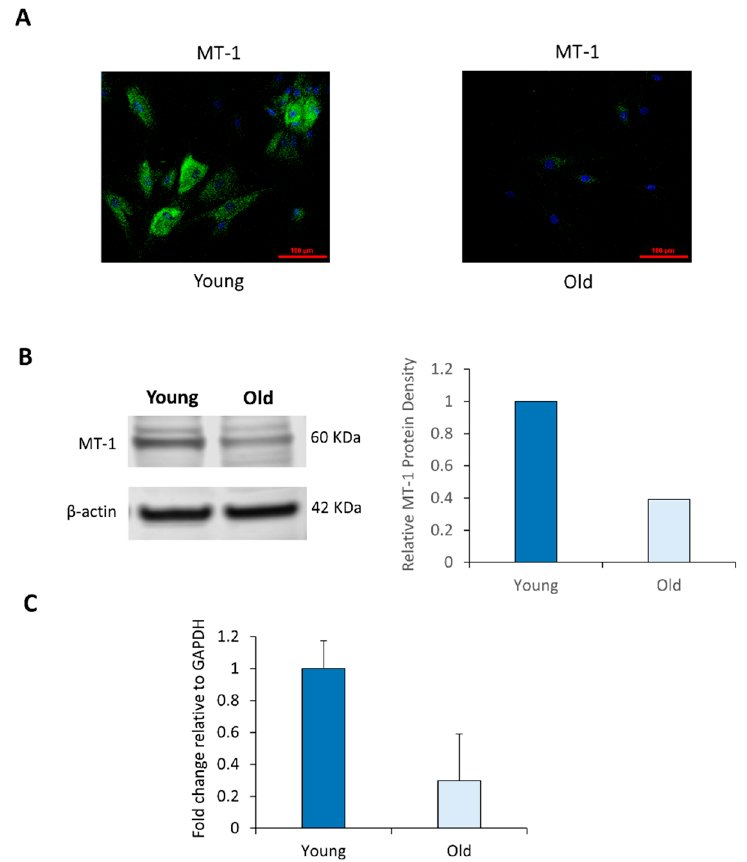
Figure 2. Expression of melatonin MT-1 receptor in adult NHDF declines with age. ( A ) MT-1 localization was visualized using specific antibodies as described in Methods. ( B ) Protein analysis by Western blot and ( C ) mRNA analysis by RT-PCR of fibroblast extracts derived from young and old subjects. Error bars are SEM.